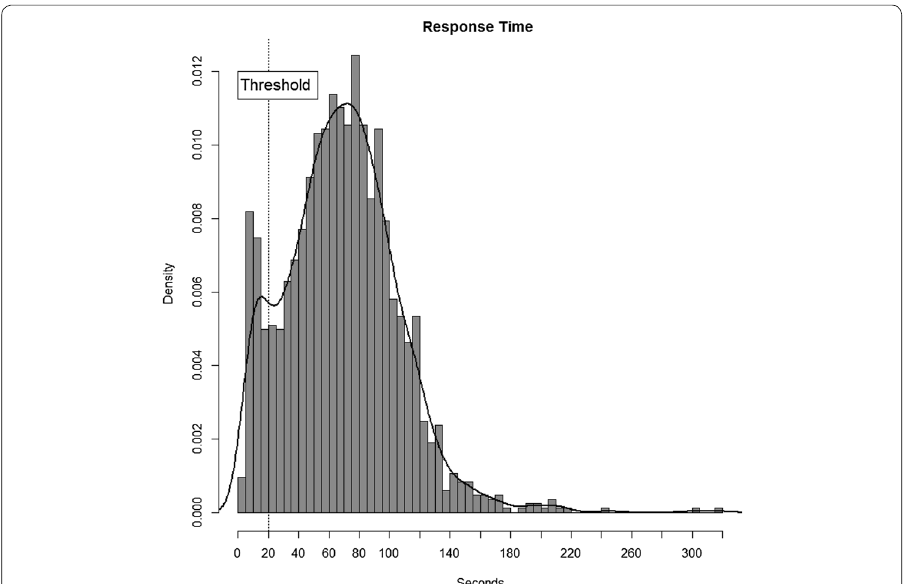
Fig. 1 Analyzing examinee effort from examinee response times. Figure is based on the concept from Kong et al.